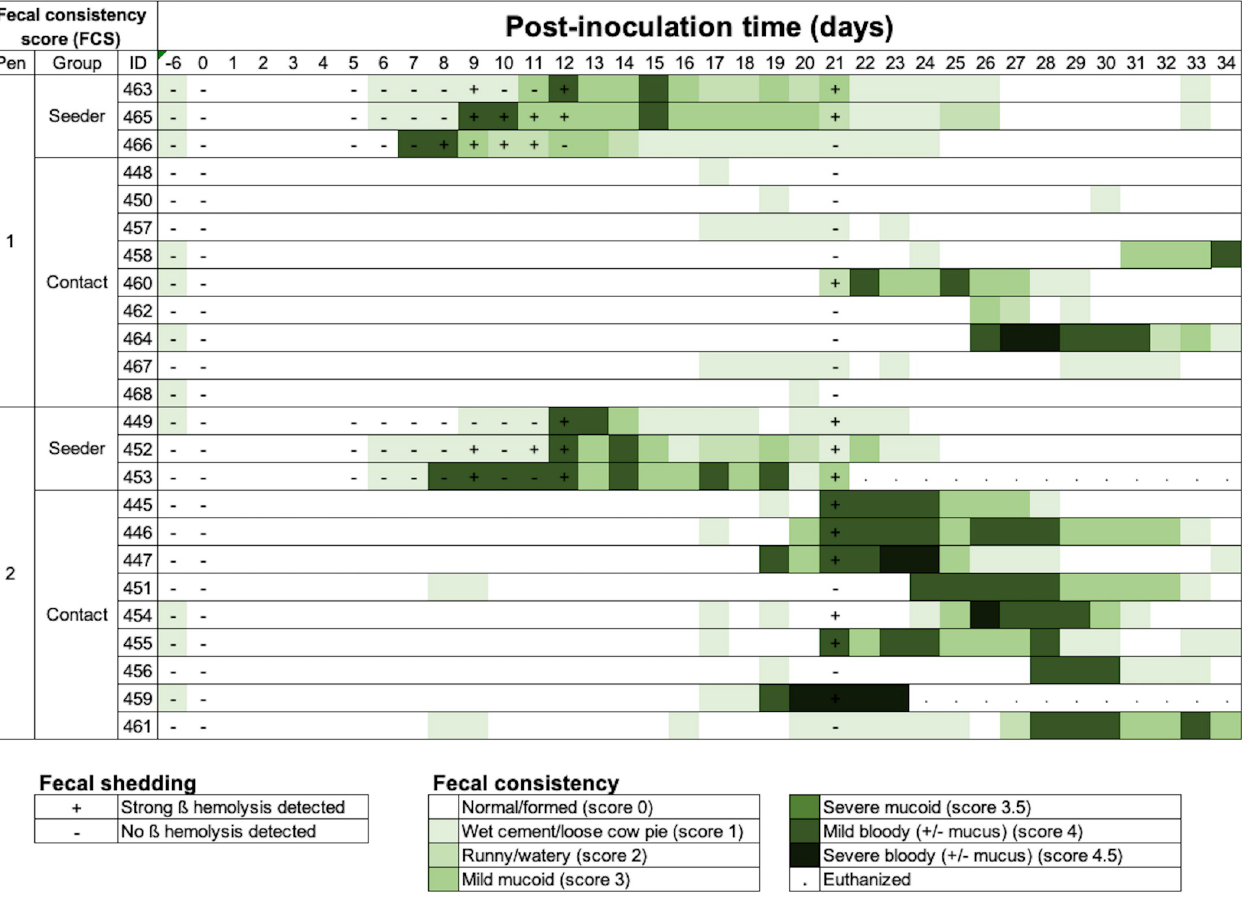
Fig 1. Trial 1 fecal culture and consistency scores (FCS) of seeder and contact pigs. Seeder pigs were inoculated with B . hampsonii strain 30446 on 0 DPI. Diarrhea severity is represented by an increasing intensity of green: 0 = normal/formed, 1 = wet cement/loose cow pie, 2 = runny/ watery, 3 = mucoid (mild/ severe), and 4 = bloody (mild/severe). Fecal shedding was semi-quantified using the culture quadrant technique with positive (strong beta hemolysis) and negative results indicated by (+) or (-), respectively. Note the greater incidence and severity of mucoid or mucohemorrhagic diarrhea in pen 2 compared to pen